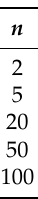
Table 2. ζ results for different n